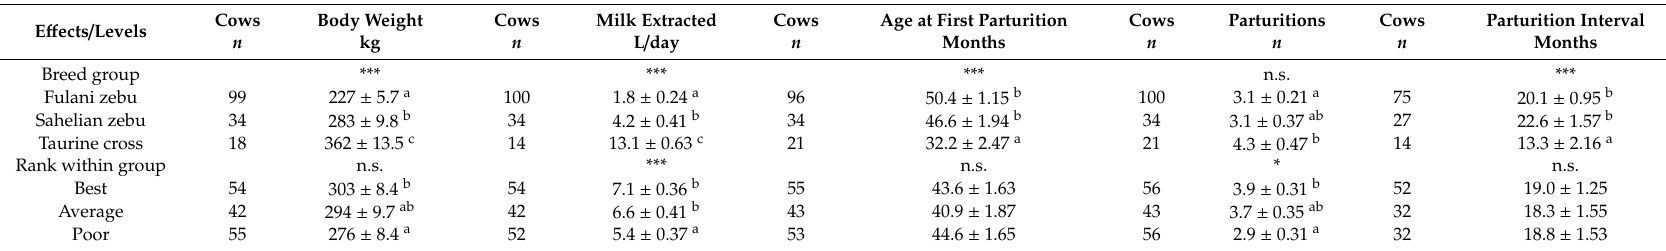
Table 5. Least-square means (LSM) ± standard error (SE) for production and reproduction traits of cows 1 owned by cattle breeders in Ouagadougou ( n = 49). Cows Body Weight Cows Milk Extracted Cows Age at First Parturition Cows Parturitions Cows Parturition Interval E ff ects / Levels n kg n L / day n Months n n n Months Breed group *** *** *** n.s. *** Fulani zebu